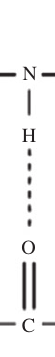
Figure 5 Single chemical bond of the IPN